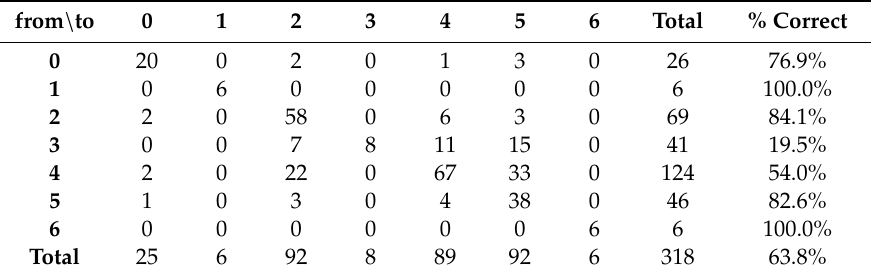
Table 3. Confusion matrix of the discriminant analysis for the total database. from \ to